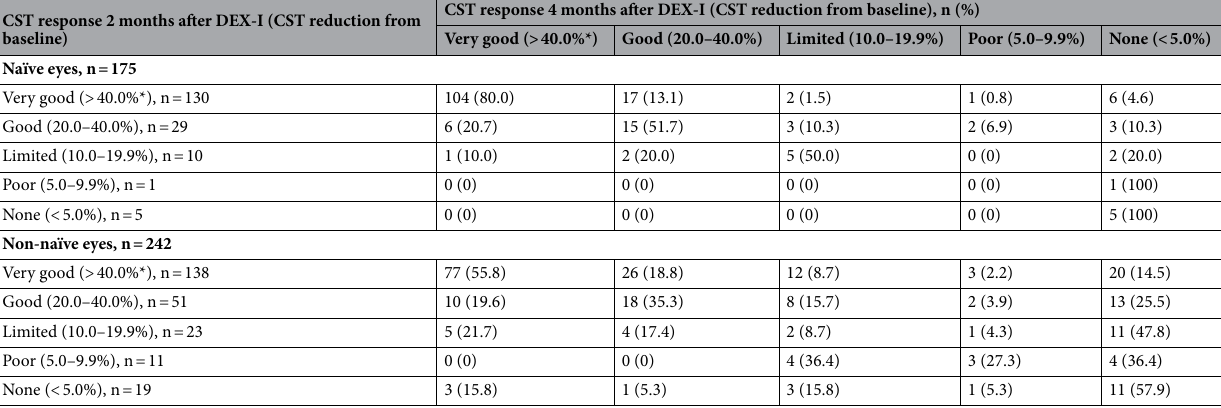
Table 4. Anatomical response at 4 months stratified for CST response after 2 months. CST—Central subfield thickness. *or CST ≤ 300